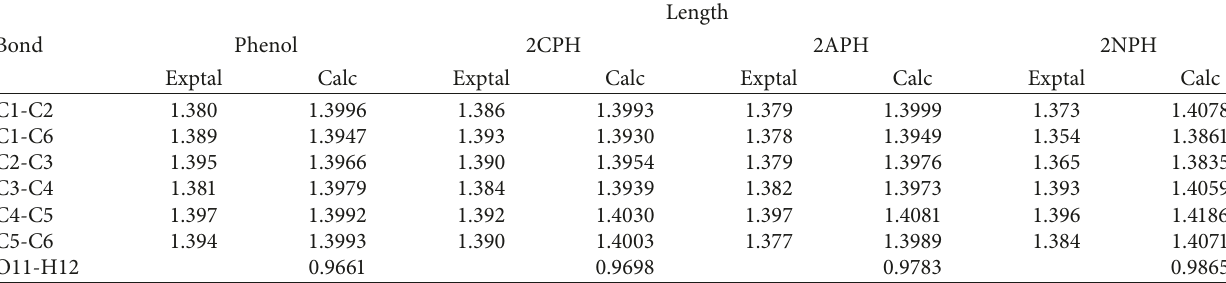
Table 3: Experimental and calculated lengths (˚A) of some selected bonds in the studied